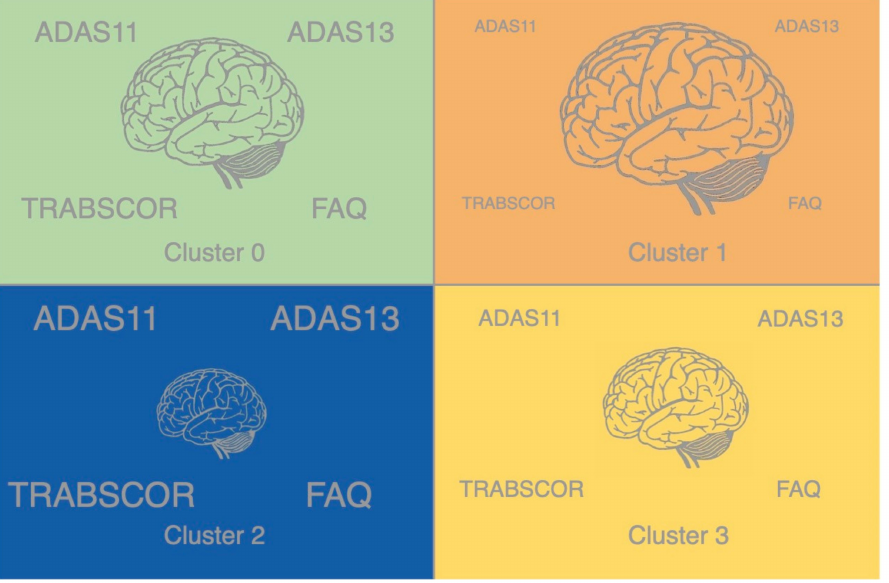
Figure 3. Visualization of the relative magnitudes of the clusters’ average brain volumes and cognitive test scores. Relative sizes indicate higher or lower metric values. Clusters ordered from highest to lowest average brain volume is: cluster 1 > cluster 0 > clusters 3 > cluster 2. Clusters ordered from best to worst cognitive performance: cluster 1 > cluster 3 > cluster 0 > cluster